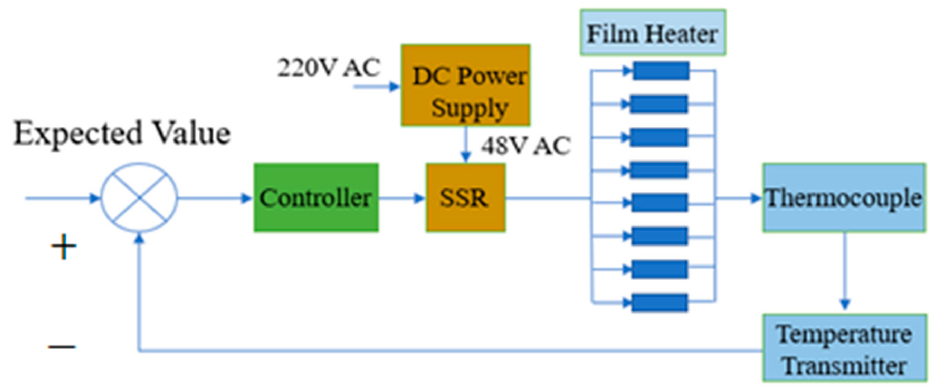
Figure 5. PID control system.